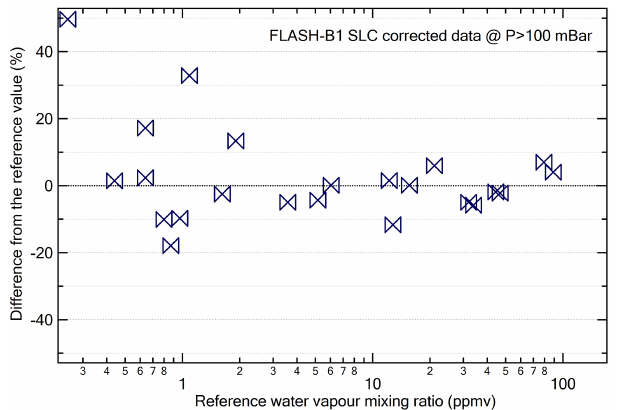
Figure A4. Summary plot of the static experiment results for FLASH-B1 data in the entire range of water vapor mixing ratios, with the data from experiments 3 and 7 recalculated using correct SLC